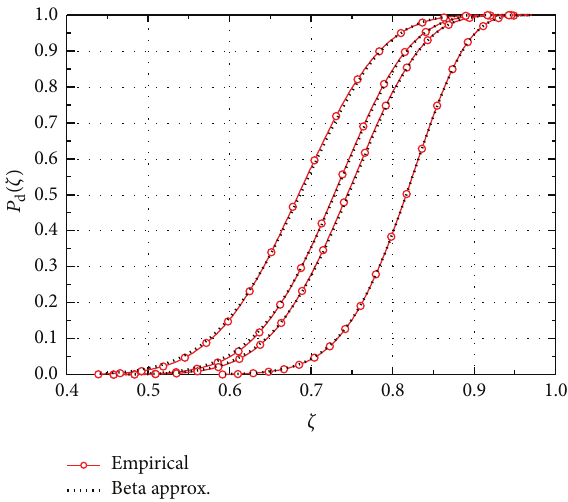
Figure 5: Variation of the detection probability of the ST with four different realizations of the channel matrix, for 𝐾 = 4, 𝑁 = 50, = − 1 dB, SNR = − 3 dB, and SNR = − 10 dB. Scenario 𝑃 = 3, SNR 1 2 3 B: fixed and nonnormalized